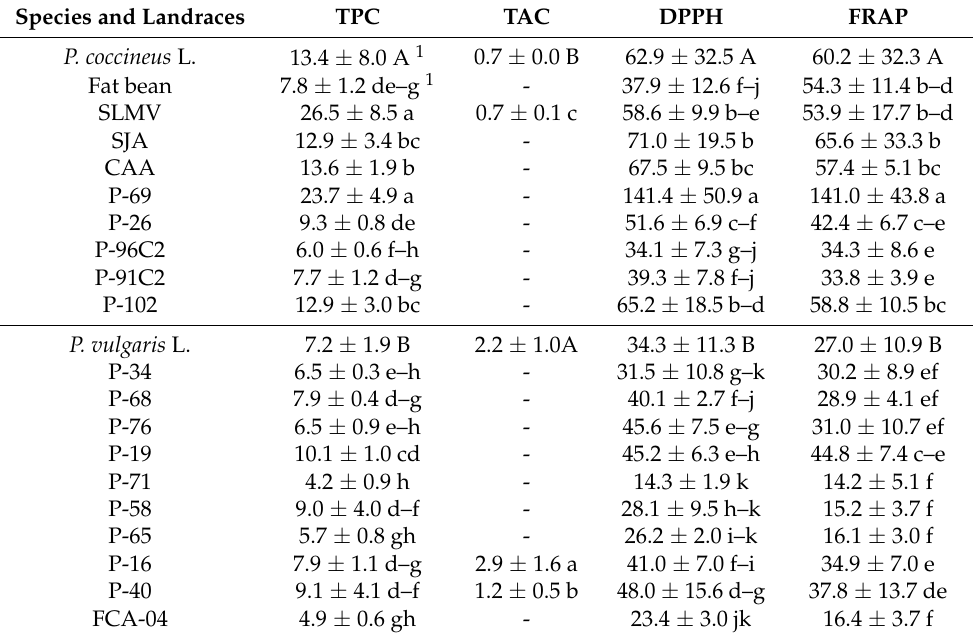
Table 3. Content of total phenols, anthocyanins, and in vitro antioxidant activity in green beans from bean